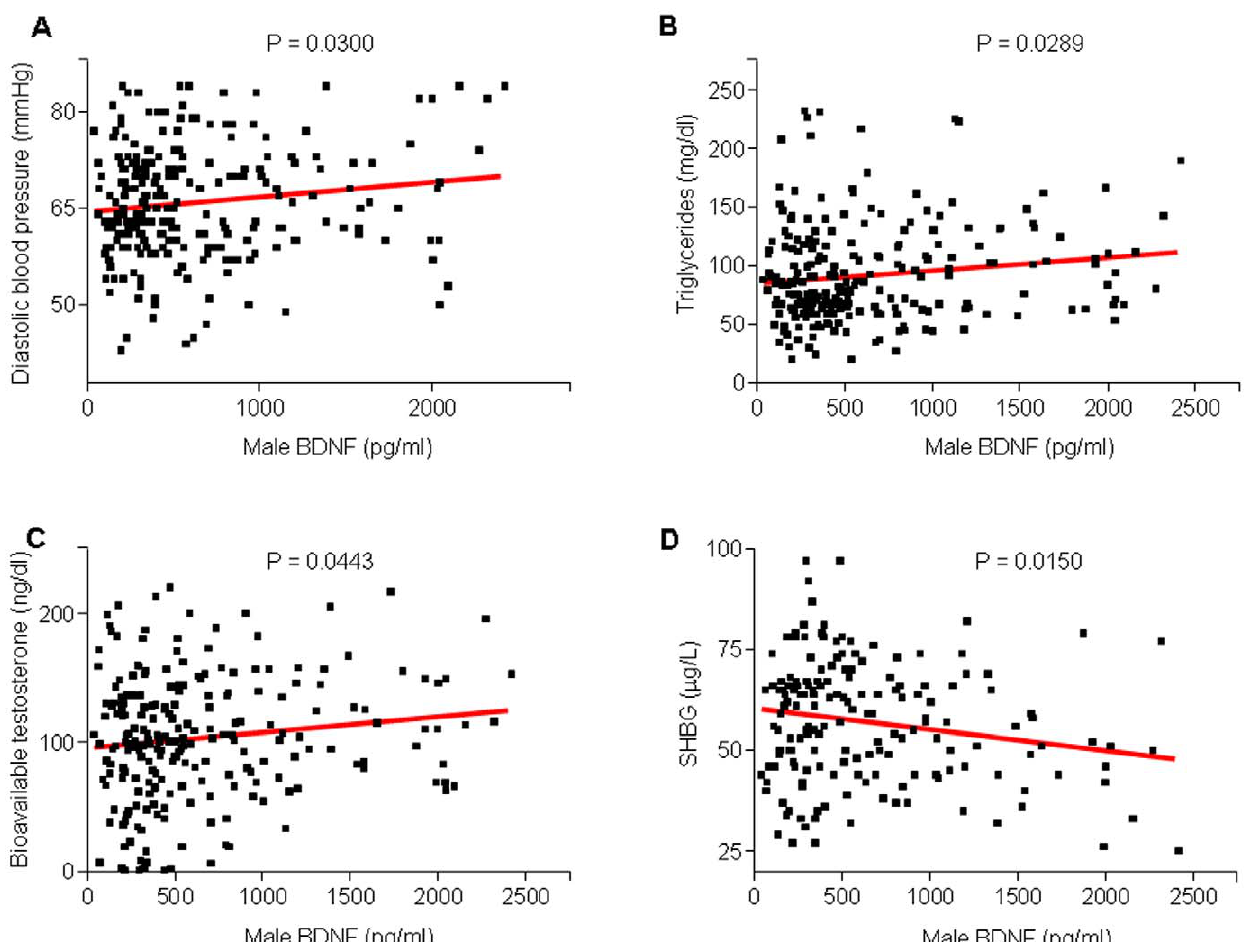
Figure 4. Linear regression analysis correlating plasma BDNF and markers of the metabolic syndrome in males. A, B and C. Plasma BDNF was positively correlated with diastolic blood pressure (p=0.0300, R 2 =0.01971), triglycerides (p=0.0289, R 2 =0.02016), and bioavailable testosterone (p=0.0443, R 2 =0.01755). D. Plasma BDNF was inversely correlated with SHBG (p=0.0150, R 2 =0.03489).